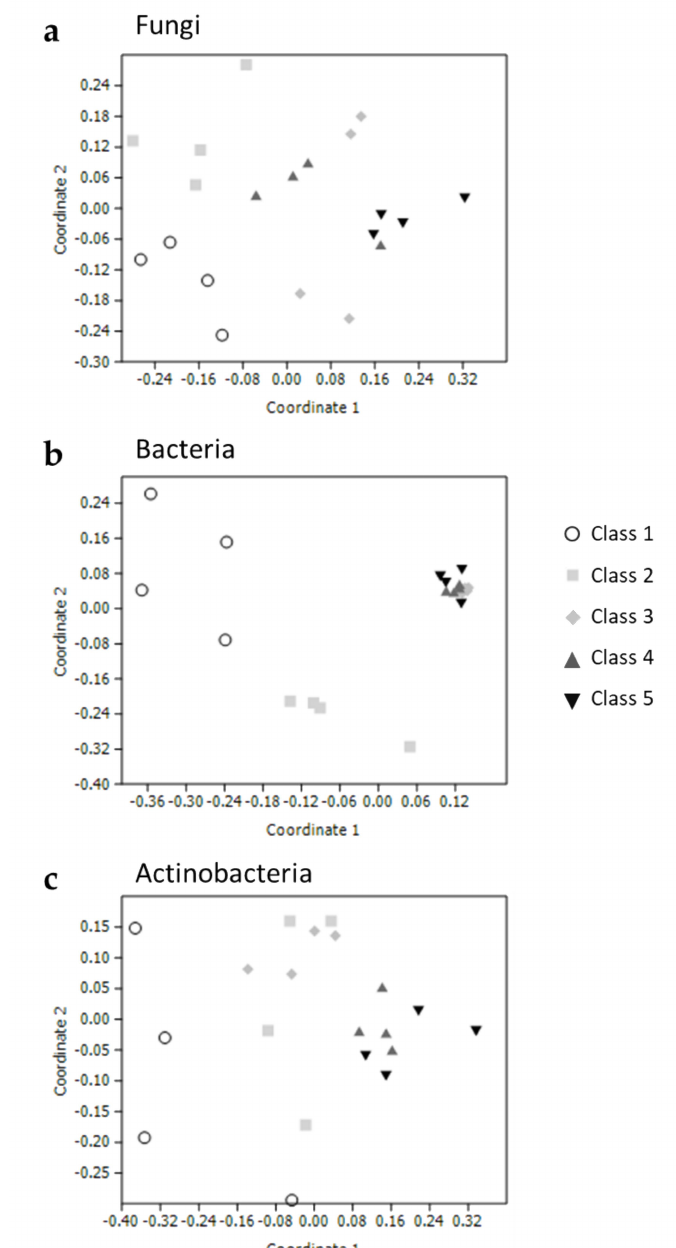
Figure 2. nMDS ordination plots of fungal 18S rDNA gene ( a ); bacterial 16S rDNA gene ( b ); and actinobacterial 16S rDNA gene ( c ) obtained by PCR-DGGE of extracted DNA from the black pine deadwood cores of the different decay